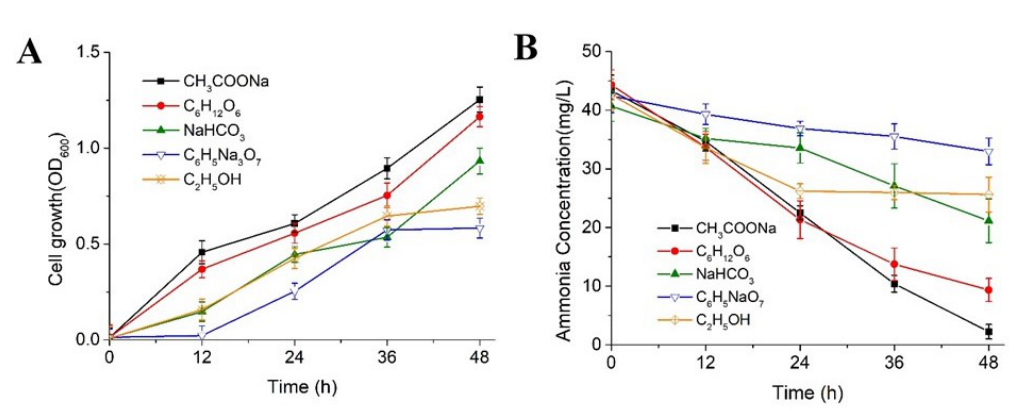
Figure 3. E ff ects of di ff erent carbon sources on the nitrogen removal capacity of strain F19. ( A ) Cell growth. ( B ) Ammonia